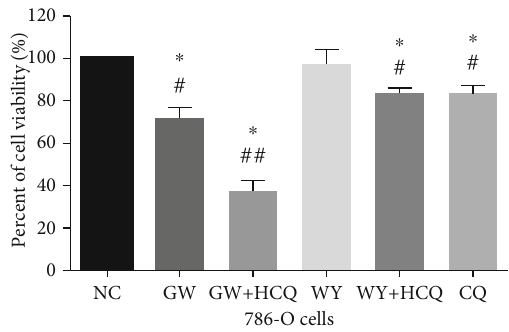
Figure 4: On cotreatment of hydroxychloroquine and GW6471, the cell viability of 786-O cells was decreased further (CCK-8 assay). ( n = 3 , one-way ANOVA with LSD ∗ P < 0 : 05 , # compared with untreated group (NC), ## compared with the group of